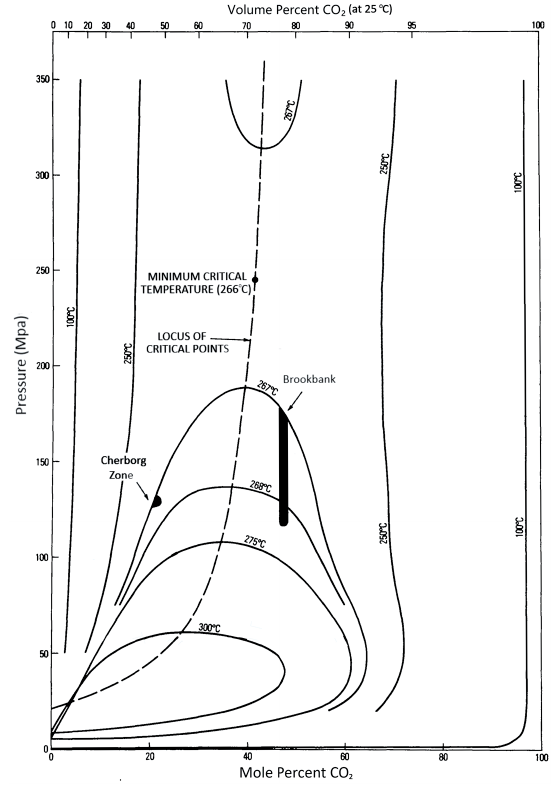
Figure 5. The CO 2 -H 2 O system with the approximate position of inclusions homogenized to vapor for Brookbank and homogenized to liquid for the Cherbourg Zone. The values of mole percent CO 2 are schematic based only on the homogenization temperatures of fluid inclusions. The effect of salinity is discussed in the text. Modified after [47]. Reproduced with permission from the Annual Reviews of Earth and Planetary Science; published by Annual